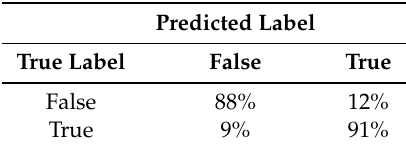
Table 2. Google’s AutoML Model Confusion